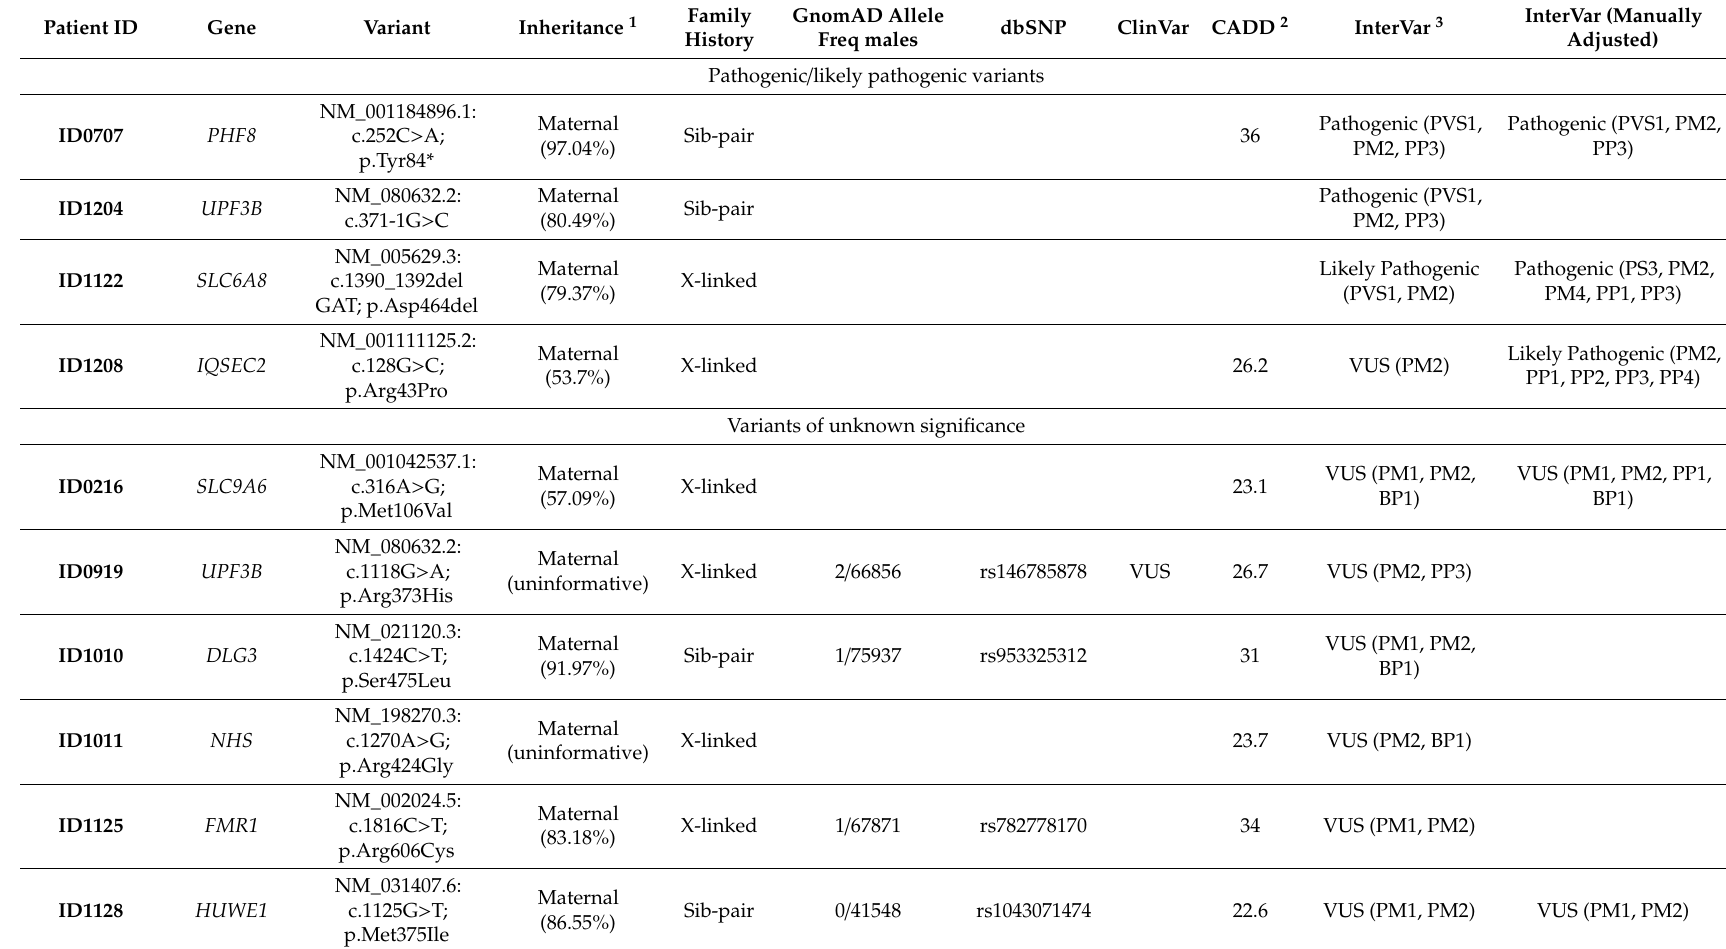
Table 2. Variants identified in our 61-patient cohort. Variants were initially classified using InterVar software and this classification was manually adjusted after segregation analysis based on the results